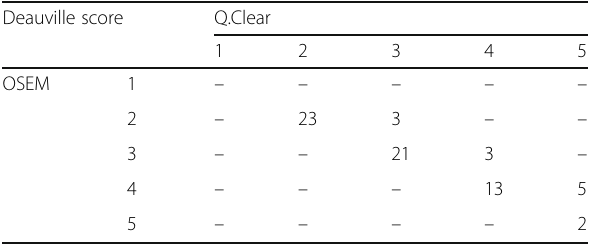
Table 2 Deauville scores obtained using Q.Clear and OSEM- interim PET Deauville score Q.Clear